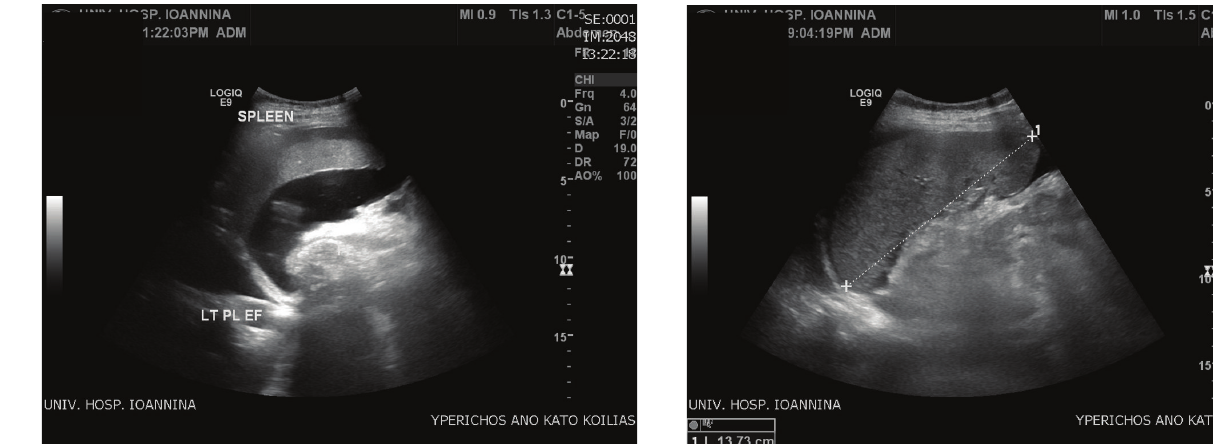
Figure 3: Splenomegaly.